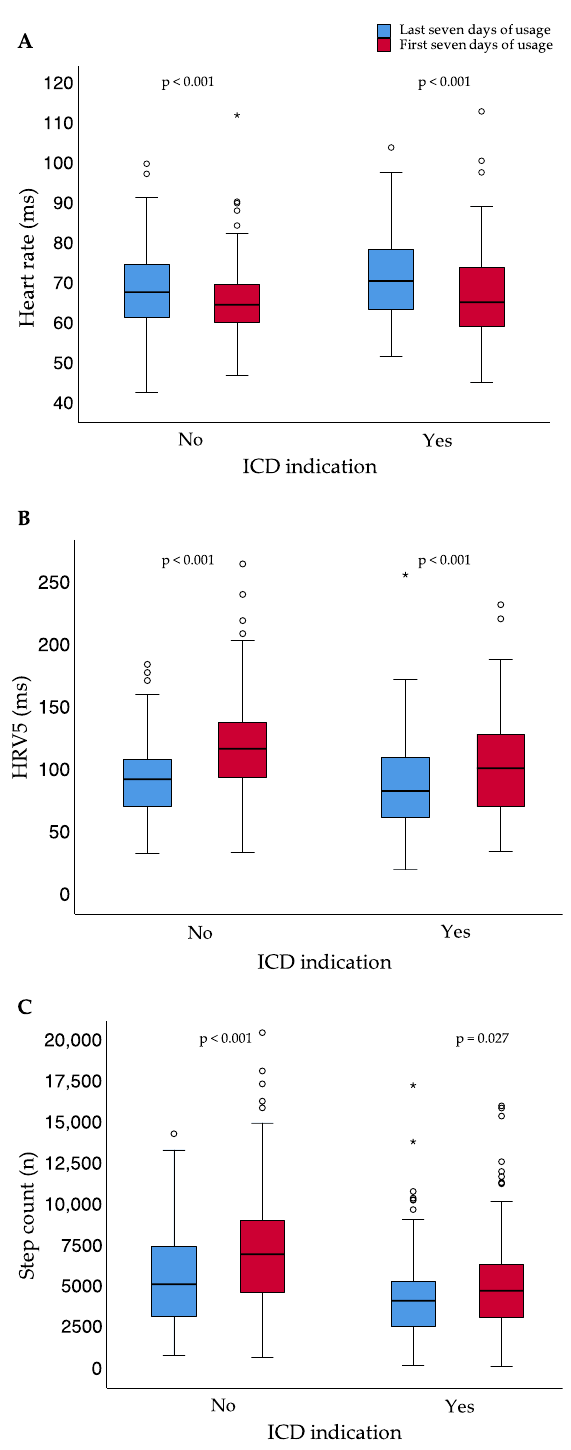
Figure 5. Heart rate ( A ), heart rate variability approximate ( B ), and step count ( C ) for the first and last seven days of usage for patients with and without ICD indication after the end of WCD prescription time; small circles represent outliers (data points outside the range of 3rd quartile + 1.5* interquartile range or 1st quartile − 1.5* interquartile range); asterisk represent extreme outliers (data points outside the range of 3rd quartile + 3* interquartile range or 1st quartile − 3* interquartile range); bpm = beats per minute; ICD = implantable cardioverter–defibrillator; HRV5 = heart rate variability